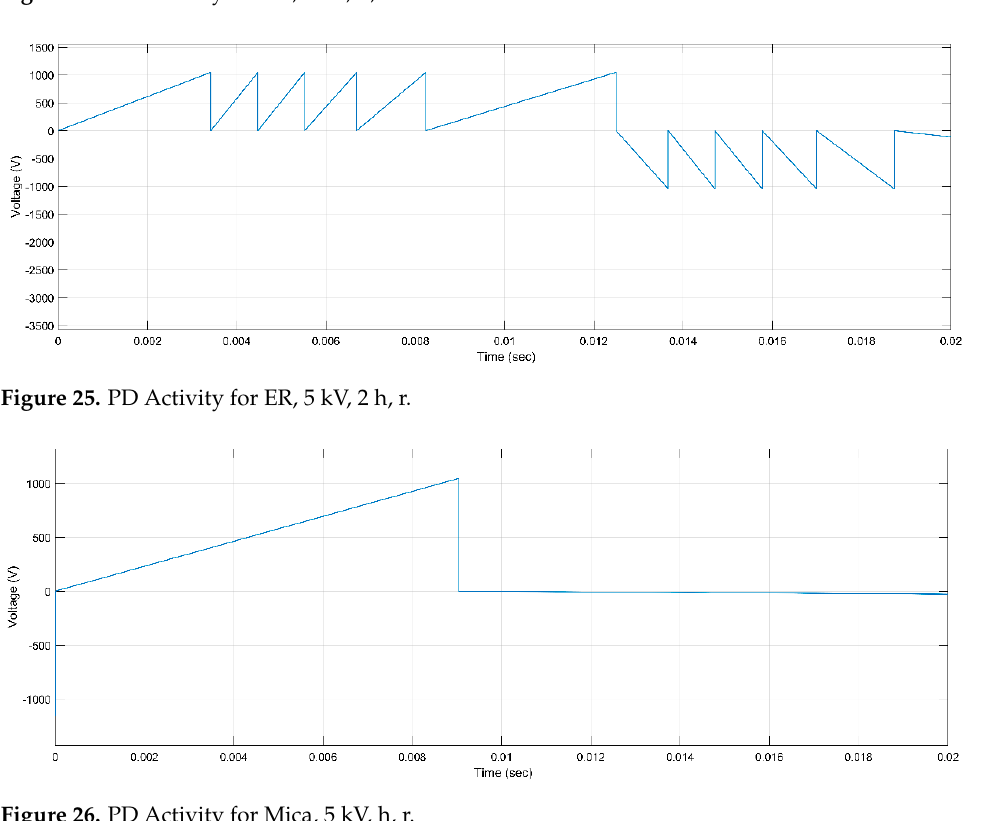
Figure 24. PD Activity for ER, 5 kV, h, 2 r.